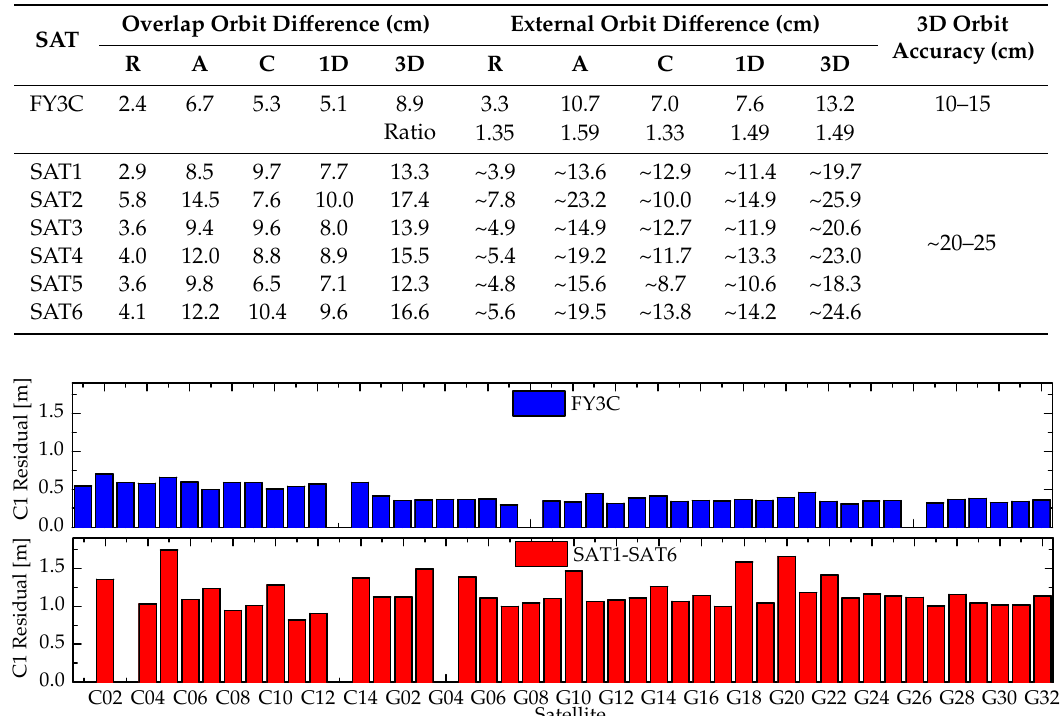
Table 2. The overall statistics of overlap and external orbit di ff erence and the inferred orbit accuracy of the FY3C and YG30 / SAT1–SAT6 satellites.